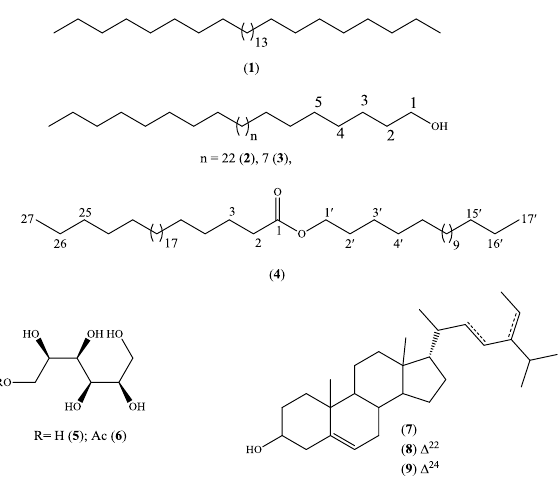
Figure 1. Isolated compounds from G. aqualla stem barks Figure 1: Isolated compounds from G. aqualla stem